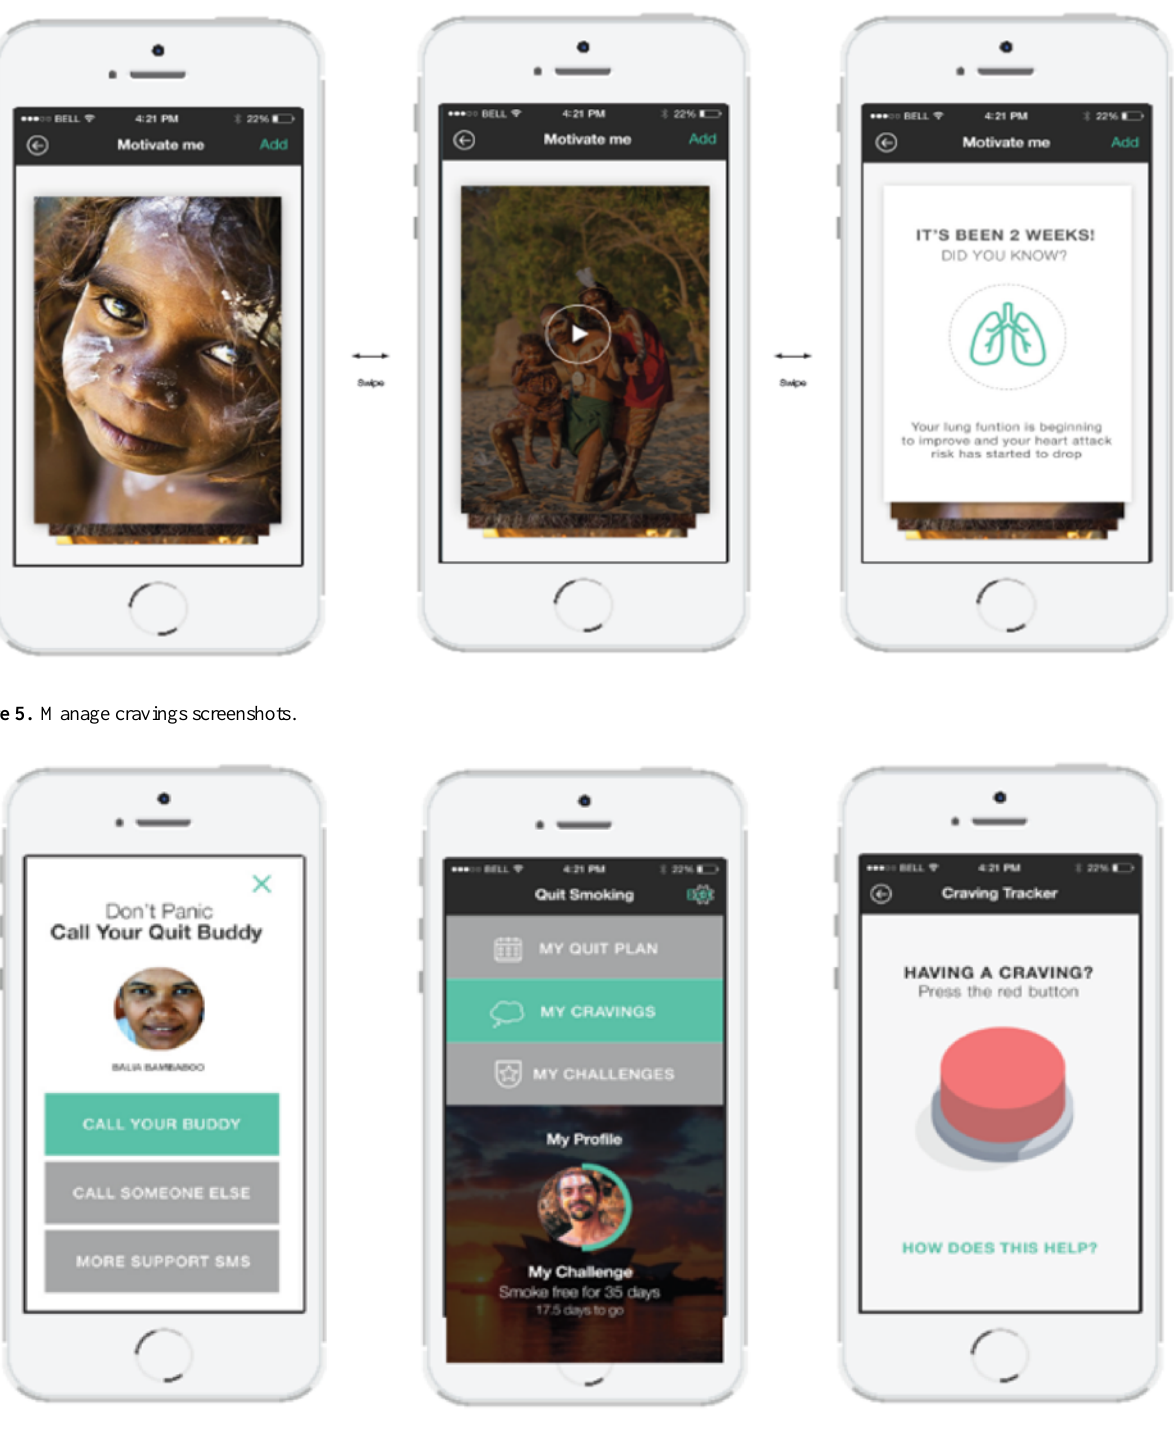
Figure 4. "Motivate me" screenshots.